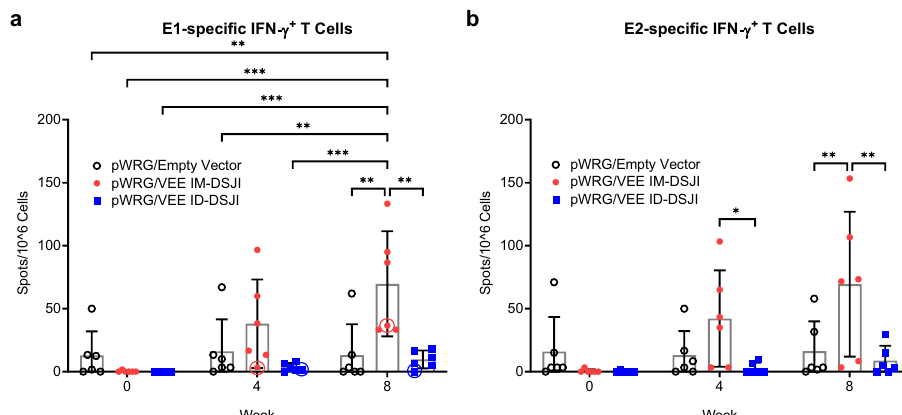
Fig. 3 pWRG/VEE delivered by IM-, but not ID-, DSJI elicits anti anti-VEEV GP cellular immunity. a VEEV E1- and ( b ) E2-speci fi c IFN- γ + T cells. Peripheral blood mononuclear cells were stimulated with pools of 15-mer, overlapping peptides spanning the VEEV E1 or E2 proteins. Data represent the group mean ± SD. Statistical analysis was performed using a two-way ANOVA with Tukey ’ s multiple comparison test. * p < 0.05, ** p < 0.01, *** p < 0.001. Circled symbols represent individual animals in VEEV-vaccinated groups that developed a fever >3 °C above baseline after VEEV aerosol challenge.